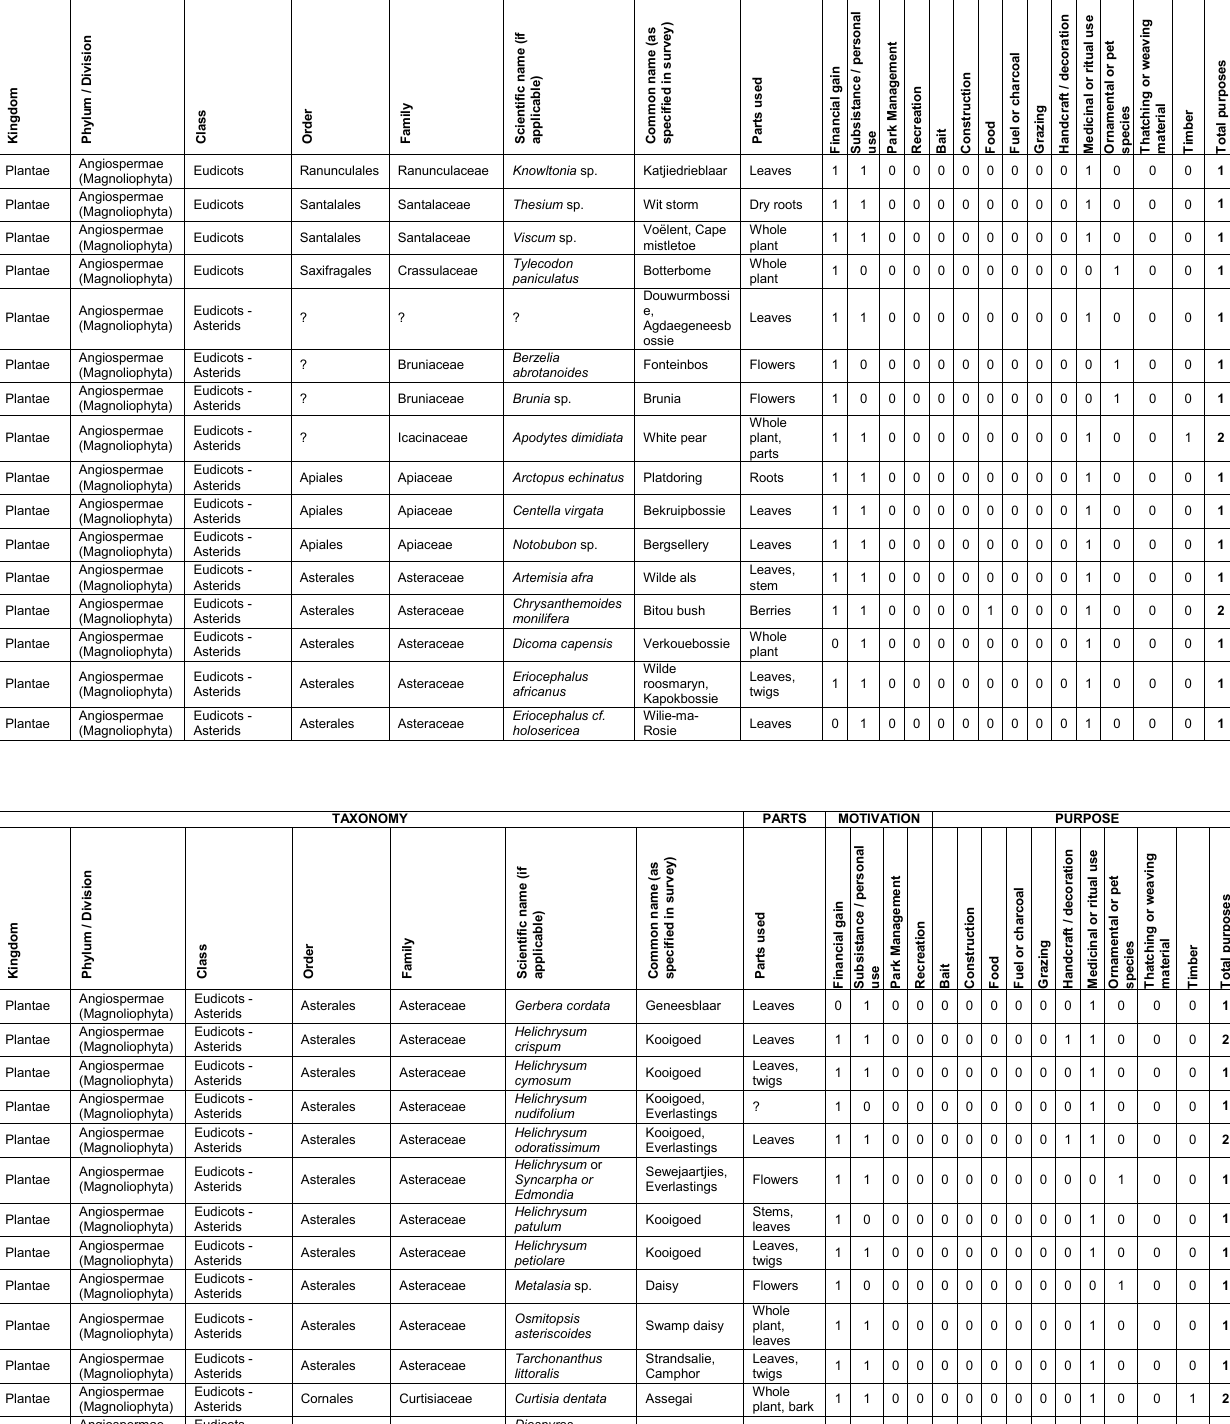
Plantae Angiospermae (Magnoliophyta) Eudicots - Asterids Cornales Curtisiaceae Curtisia dentata Assegai Plantae Angiospermae (Magnoliophyta) Eudicots - Asterids Ericales Ebenaceae Diospyros whyteana Bladder nut ? 0 1 Plantae Angiospermae (Magnoliophyta) Eudicots - Asterids Ericales Ericaceae Erica plukenetii Erica Flowers 0 Plantae Angiospermae (Magnoliophyta) Eudicots - Asterids Ericales Ericaceae Erica sp. Erica species Flowers Plantae Angiospermae (Magnoliophyta) Eudicots - Asterids Ericales Myrsinaceae Rapanea melanophloeos Cape Beech Bark 1 1 0 0 0 0 0 0 0 0 1 0 Plantae Angiospermae (Magnoliophyta) Eudicots - Asterids Ericales Sapotaceae Englerophytum magalismontanum Transvaal milk plum